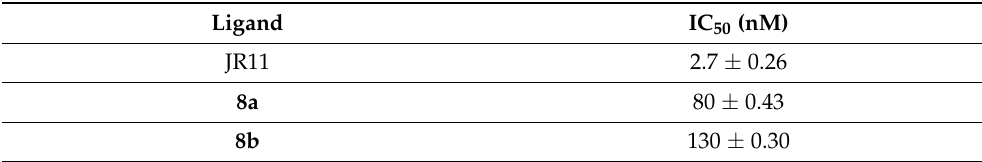
Table 2. In vitro competitive binding assays for compounds 8a and 8b in increasing concentrations (M) with [ 177 Lu]Lu-JR11 as radioligand.